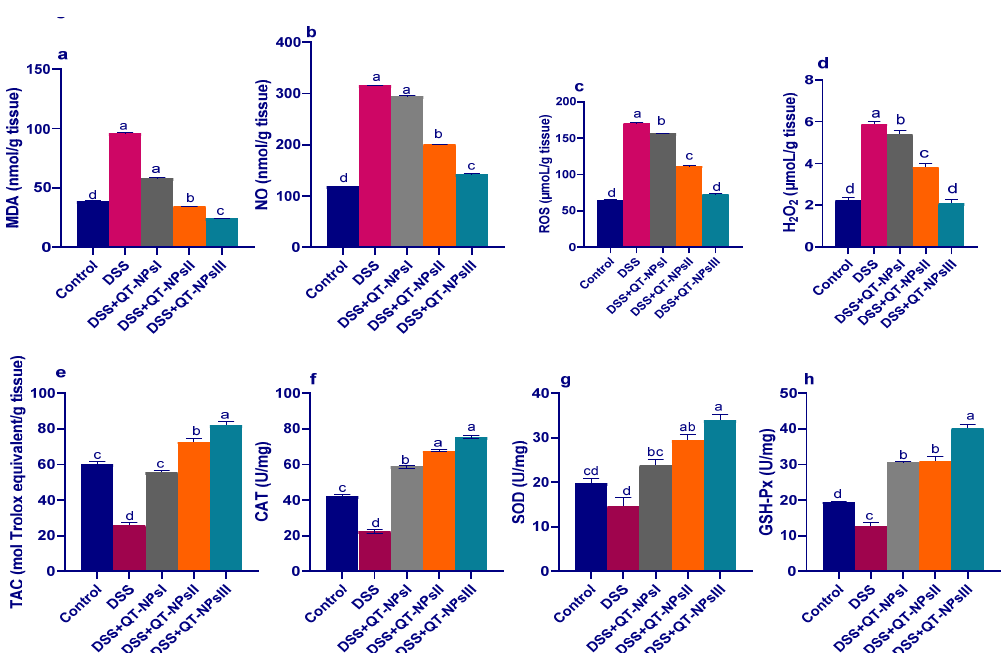
Figure 5. Impacts of quercetin-loaded nanoparticles (QT-NPs) therapy on MDA ( a ), nitric oxide (NO) ( b ), ROS ( c ), H 2 O 2 ( d ), total antioxidant capacity (TAC) ( e ), CAT ( f ), SOD ( g ), and GSH-Px ( h ). Fourteen days post DSS induction. Control: healthy non-colitic group (rats orally gavaged with PBS); colitic groups: DSS (rats orally gavaged with dextran sodium sulphate), DSS + QT-NPsI (rats orally gavaged with DSS and quercetin-loaded nanoparticles (QT-NPs at the level 10 mg/kg body weight for 14 days)), DSS + QT-NPsII (rats orally gavaged with DSS and quercetin-loaded nanoparticles (QT-NPs at the level 15 mg/kg body weight for 14 days)), and DSS + QT-NPsIII (rats orally gavaged with DSS and quercetin-loaded nanoparticles (QT-NPs at the level 20 mg/kg body weight for 14 days)). All groups orally gavaged by 3% DSS. a,b,c,d Means of the rows with different letters were significantly different among groups ( p < 0.05).